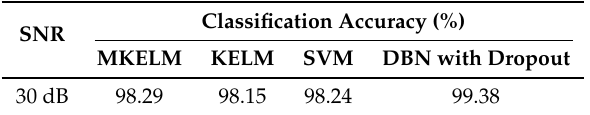
Table 5. Comparison of the classification performance between the proposed and existing fault detection and classification (FDC) methods.